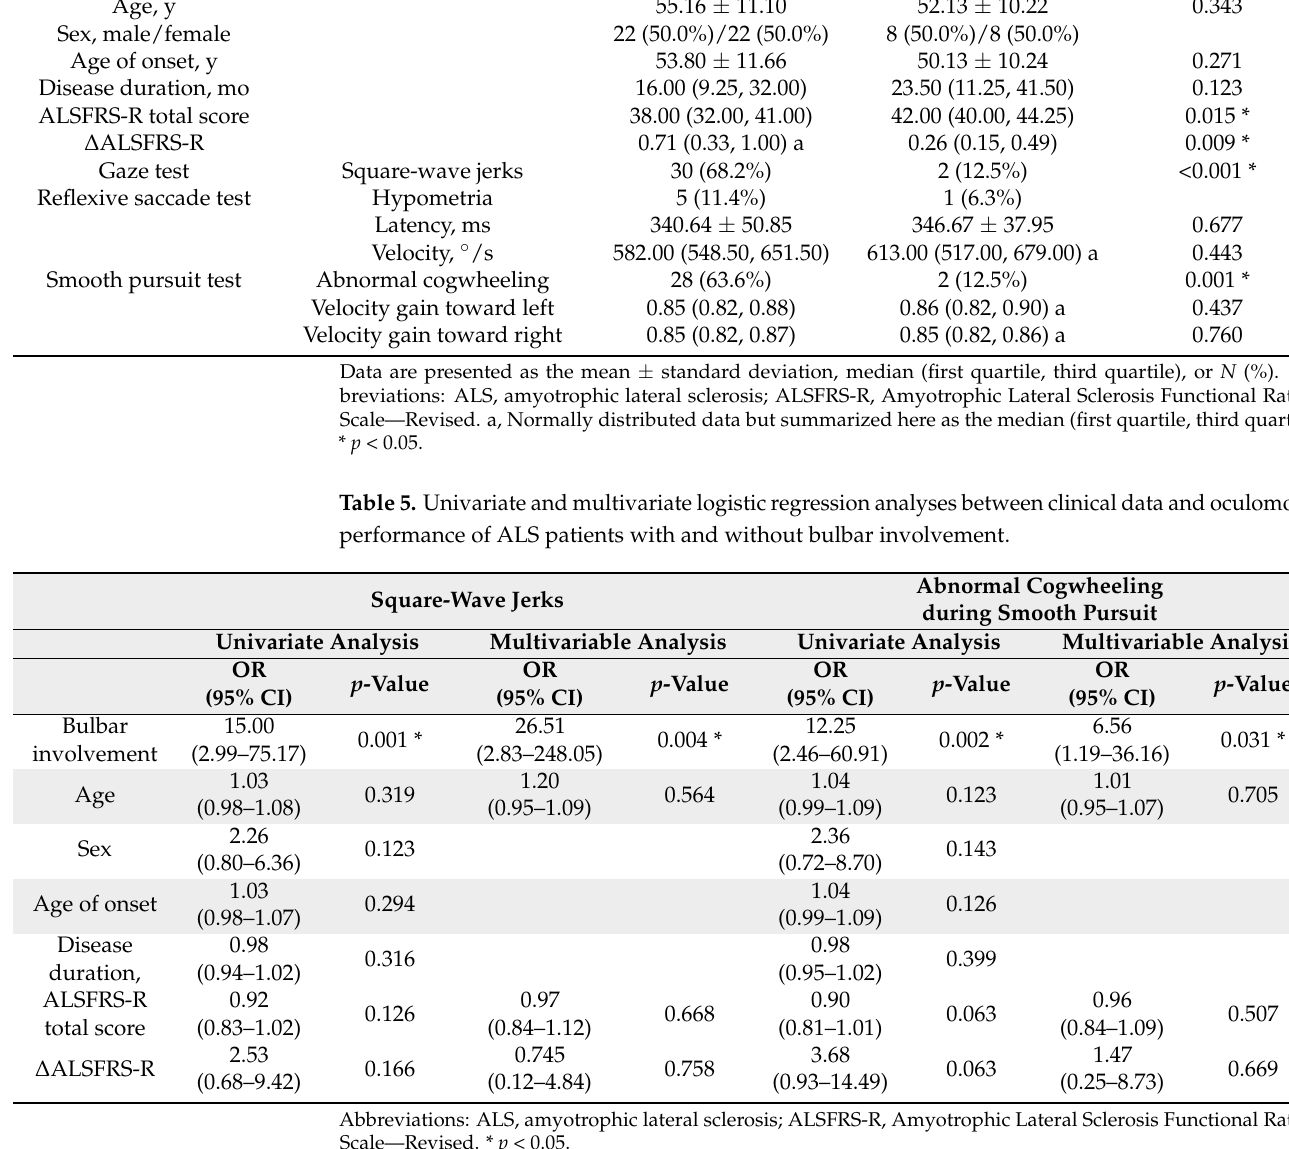
Table 4. Clinical data and oculomotor performance of ALS patients with and without bulbar involvement. ALS Patients without ALS Patients with Bulbar Involvement Bulbar Involvement ( n = 44)